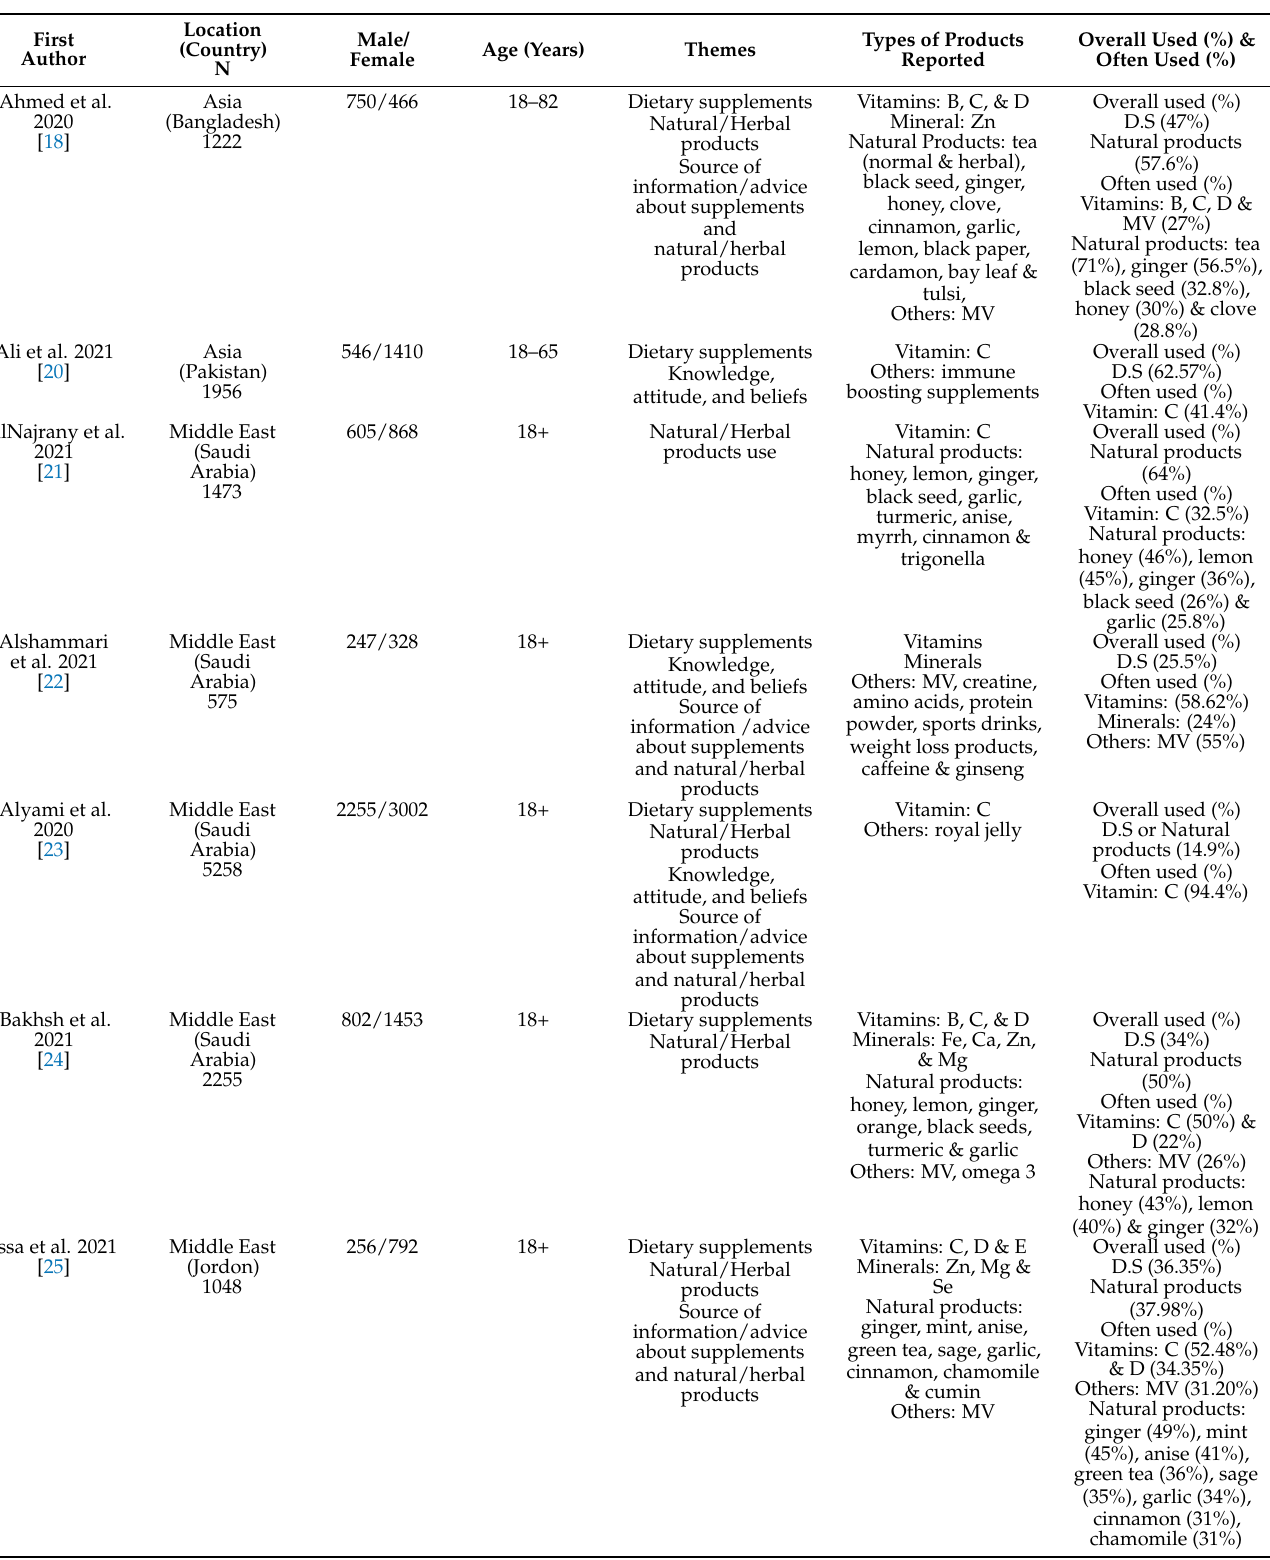
Table 1. Characteristics of cross-sectional studies from scoping search, by reported themes and dietary supplement